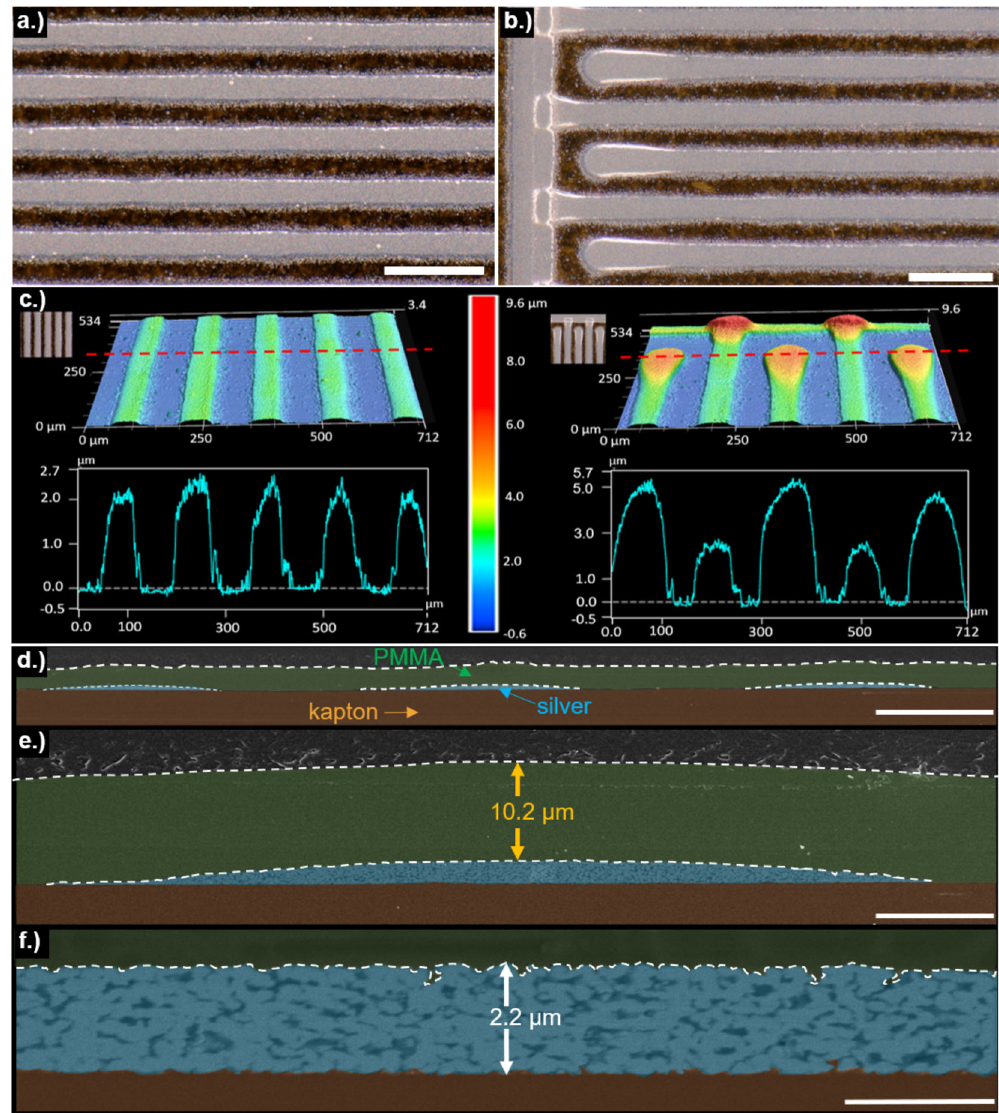
Fig. 2 Micrographs depicting the morphology of silver lines deposited with aerosol jet printing. a and b Optical microscope images of silver strain gauge on polyimide substrate (Scale bar represents 250 µm), and the c optical pro fi lometry of AJP deposited silver electrodes on polyimide. Cross-sectional scanning electron microscopy characterization to show d silver electrodes representative of AJP deposited strain gauges (scale bar represents 50 µm), e PMMA dielectric thickness (scale bar represents 10 µm) and f printed silver thickness (scale bar represents 2.5